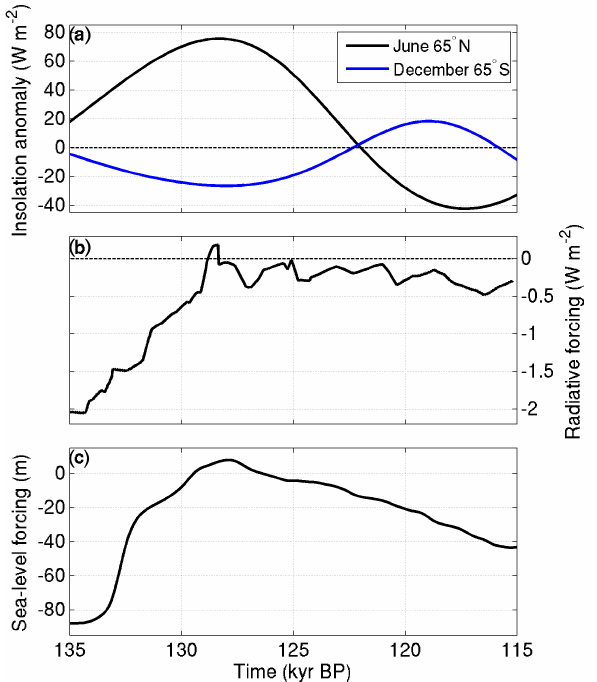
Figure 2. Prescribed model forcing. (a) Average monthly insola- tion anomaly at 65 ◦ N in June (black) and 65 ◦ S in December (blue) to illustrate the spatially and temporally resolved forcing (Berger, 1978), (b) combined radiative forcing anomaly of prescribed green- house gas concentrations relative to the present day, and (c) sea- level forcing for the ice sheet components derived from a Red Sea sea-level record (Grant et al., 2012).